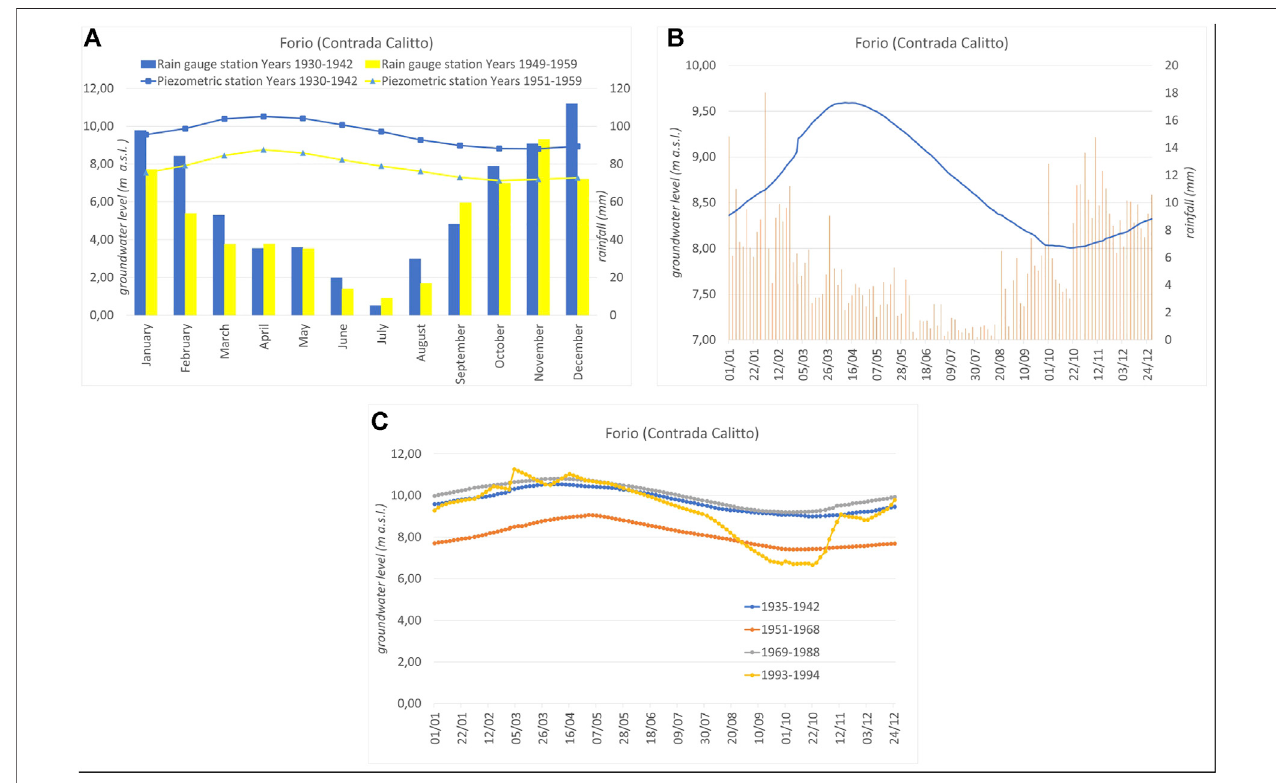
FIGURE 3 | Analysis of the groundwater level fl uctuations measured in the National Hydrographic and Mareographicmonitoring well “ Forio (Contrada Calitto) ” : (A) comparisonbetweentheaveragemonthlygroundwaterlevelandrainfall; (B) comparisonbetweentheaveragedailygroundwaterlevelandrainfallobservedfrom1935to 1959; (C) comparison of the groundwater fl uctuations for speci fi c time periods. The well location is shown in Figure 2 .